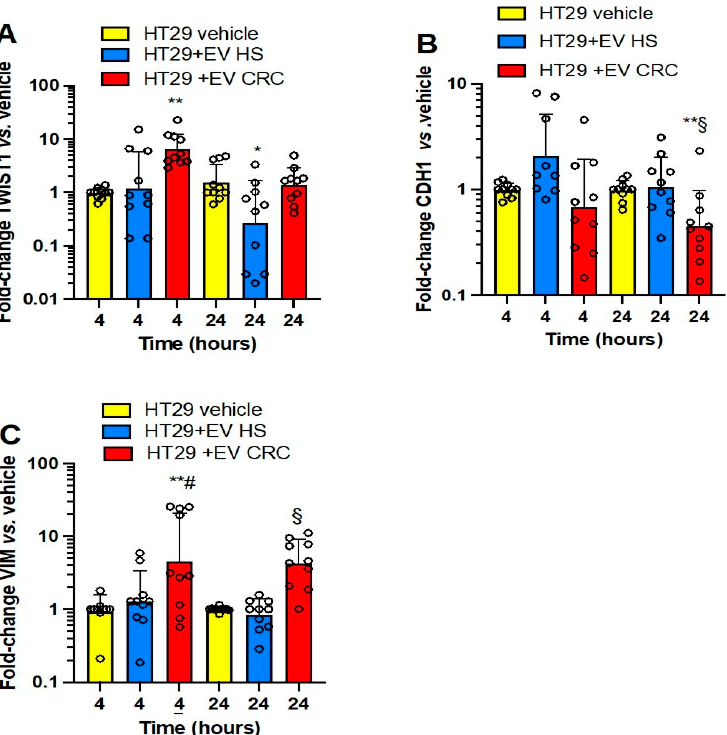
Figure 4. Effects of platelet-derived mEVs on the expression of gene markers of EMT in cocultures with the human colorectal adenocarcinoma cell line HT29. Cancer cells (0.5 × 10 6 ) were incubated for 4 or 24 h with CRC or HS EVs (100 μ g), and the gene expression of TWIST1 ( A ), CDH1 (protein name E-cadherin) ( B ), and VIM (protein name vimentin) ( C ) was evaluated by qPCR and normalized to those of GAPDH and reported as fold-change vs. the gene expression detected in the cocultures of mEV from HS with the cancer cells. The values were not normally distributed and were transformed to logarithms, and all values are shown as scatter dot plots with mean + SD, n = 10, and analyzed by one-way ANOVA followed by Tukey’s multiple comparisons test. ( A ) TWIST1 , 4 h,** p < 0.01 vs. vehicle, 24 h, * p < 0.05 vs. vehicle and EV CRC; (B) CDH1 , 24 h, ** p < 0.01 vs. EV HS, § p < 0.05 vs. vehicle; ( C ) VIM , 4 h, ** p < 0.01 vs. vehicle, # p < 0.05, 24 h, § p < 0.01 vs. vehicle and EV HS.